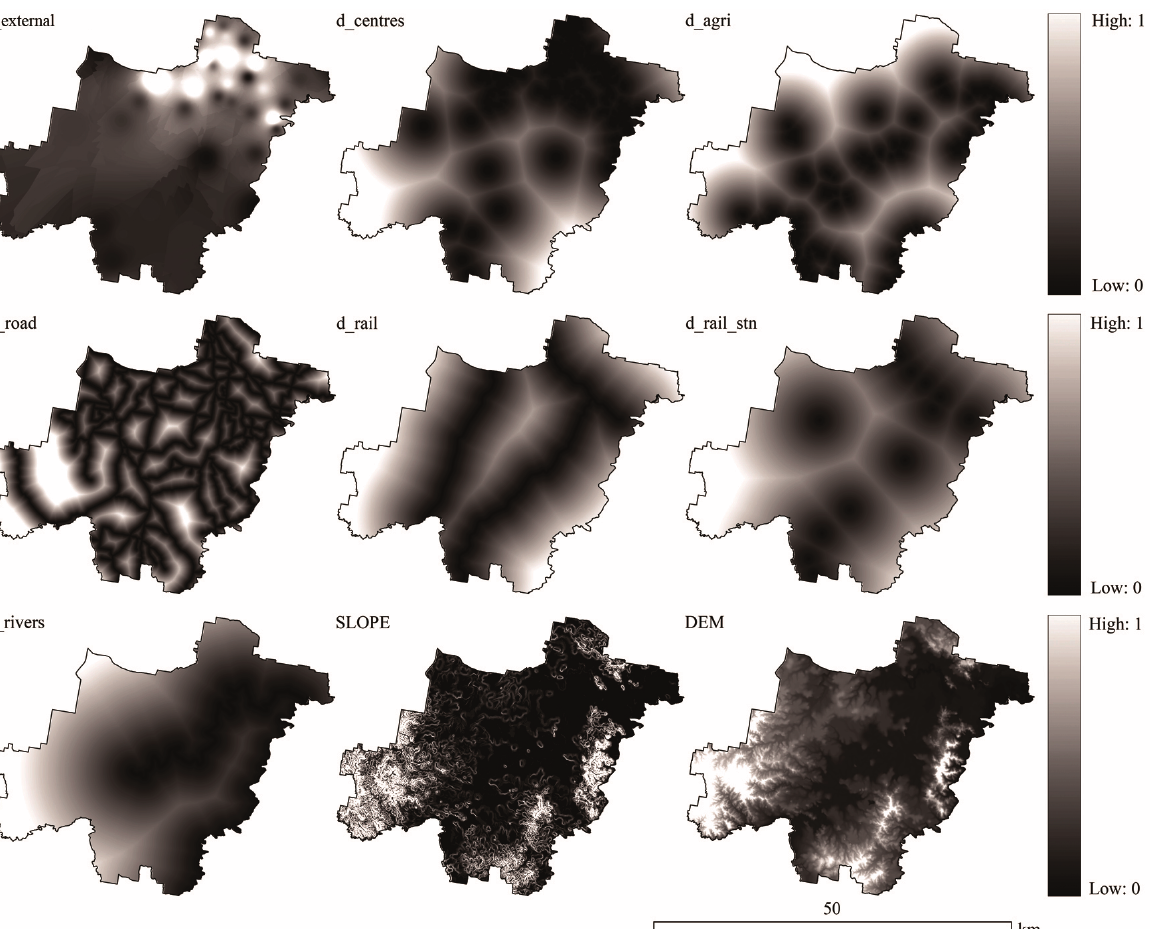
Figure 3. Spatial variables used in the SAGA-CA model in Logan City,